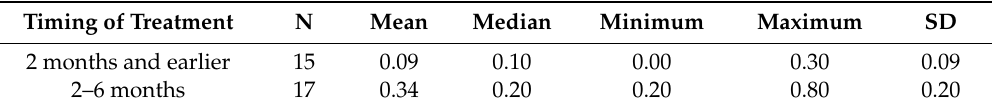
Table 4. LogMAR values of final BCVA for the subgroups of patients according to the time point of initiation of